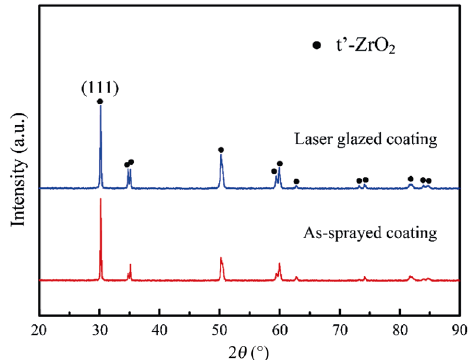
Fig. 4 XRD patterns of the as-sprayed and laser glazed YSZ